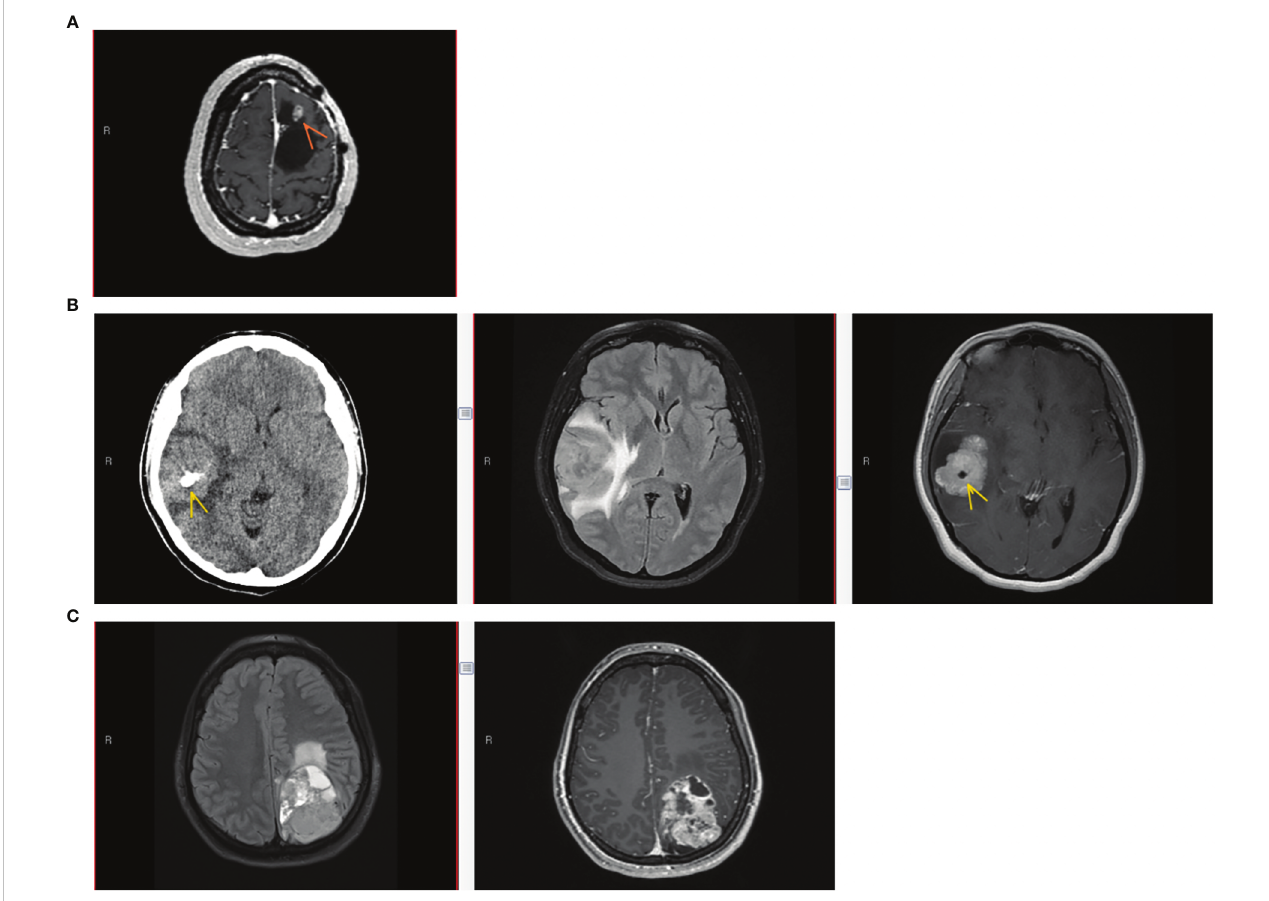
FIGURE 1 Patient imaging fi ndings. (A) Patient #1 imaging fi ndings at 3 rd recurrence. Axial T1-weighted MRI with gadolinium showing an enhancing nodule (arrow) along the anterior-superior margin of the previous left frontal resection cavity. (B) Patient #2 imaging at initial presentation. Left to right: Axial CT without contrast, Axial T2/FLAIR MRI, and Axial T1-weighted MRI with gadolinium. Lobular homogeneously enhancing mass with cystic component in the right frontotemporal region, with vasogenic edema, mass effect, midline shift, and intratumoral calci fi cation (arrow). (C) Patient #3 imaging at initial presentation. Left to right, Axial T2/FLAIR MRI, and Axial T1-weighted MRI with gadolinium. Large heterogeneously enhancing left parieto-occipital mass with perilesional edema and midline